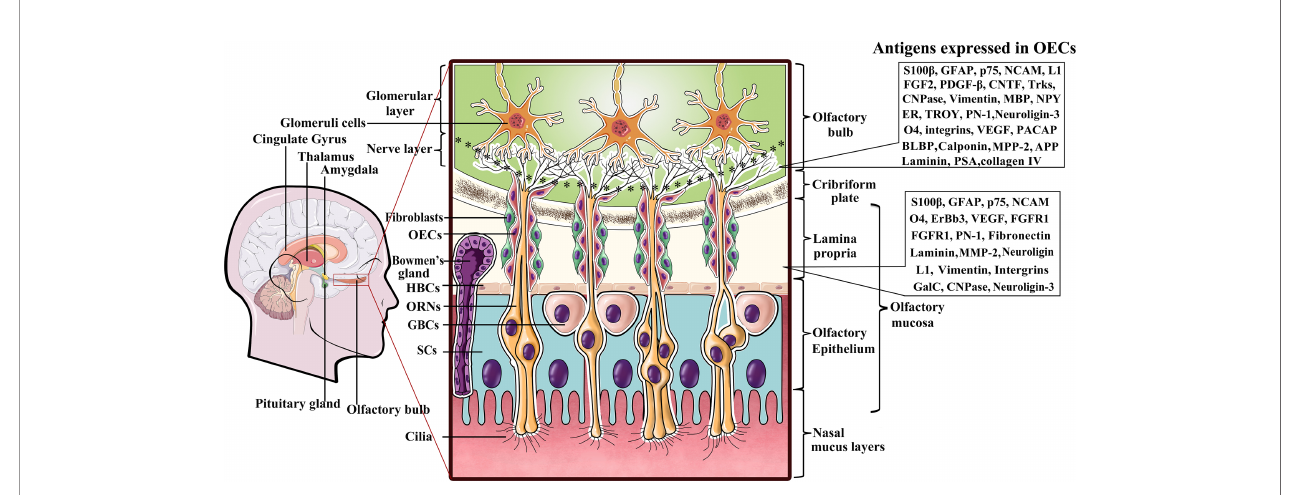
FIGURE 1 | A diagram representing location of olfactory ensheathing cells (OECs) and antigen expression within the primary olfactory system. Listed to the right are several molecules expressed by OECs in the LP and ONL. OECs wrap fascicles of ORN axons along their tortuous route through the LP in the PNS. Olfactory nerves and concomitant OECs pass through the cribriform plate of the skull and enter the OB in the CNS to form the ONL. ORN axon terminals into glomerular layer to form asymmetrical synaptic contacts with glomeruli cells. LP, lamina propria; ORNs, olfactory receptor neurons; GBCs, globose basal cells; HBCs, horizontal basal cells; SCs, sustentacular